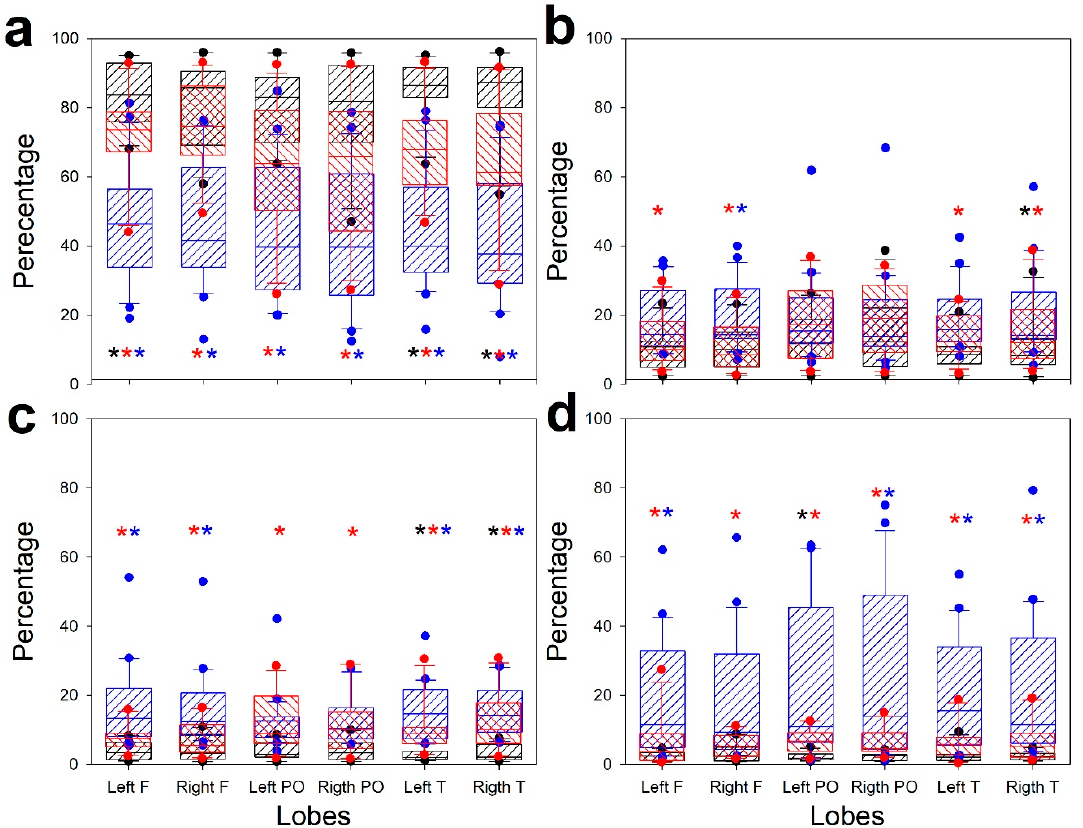
Figure 3. Box plots showing comparison of EEG structure for di ff erent bands: ( a ) delta, ( b ) theta, ( c ) alpha, and ( d ) beta. Striped black box: ECN; striped red box: COVID; striped blue box: CRA; black asterisk: di ff erence between ENC and COVID; red asterisk: di ff erence between ENC and CRA; blue asterisk: di ff erence between COVID and CRA.